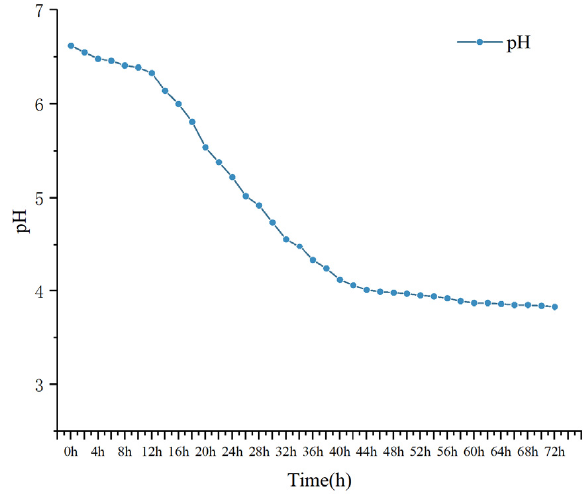
Figure 8. The trend of pH of M3 (1)-fermented milk.